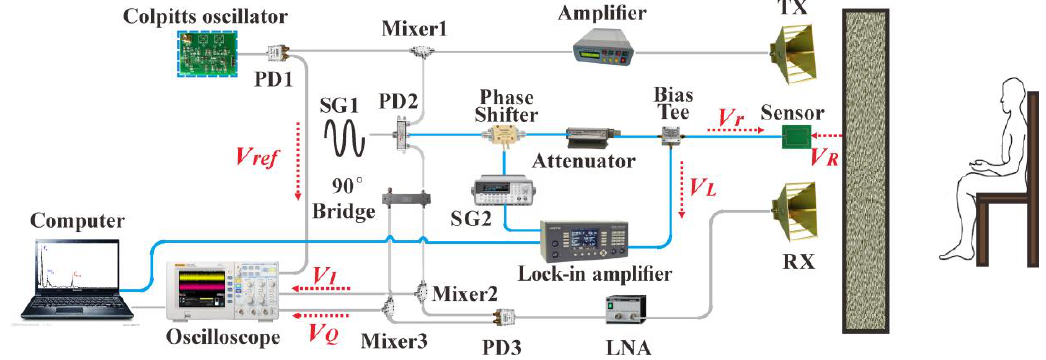
Figure 3. Experimental setup of the proposed life signal detection radar. PD: power divider; LNA: low noise amplifier ; SG: signal generator.